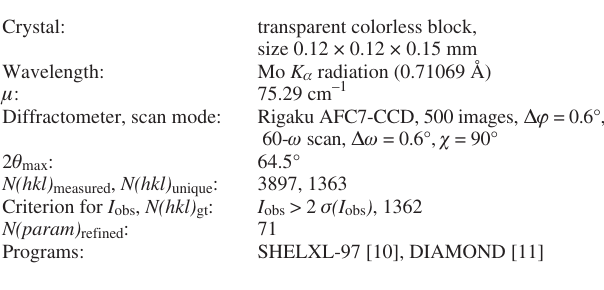
Table 1. Data collection and